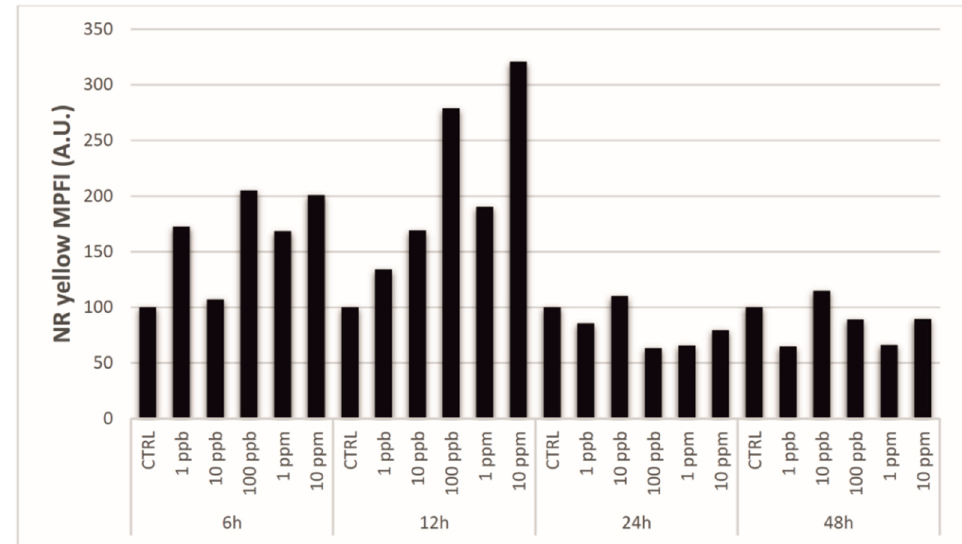
Figure 4. Histogram of yellow mean fluorescence intensity (MFI) expressed in arbitrary units (A.U.) for the treatments (control and five Cd-concentrations) and over time (6 h, 12 h, 24 h and 48 h).